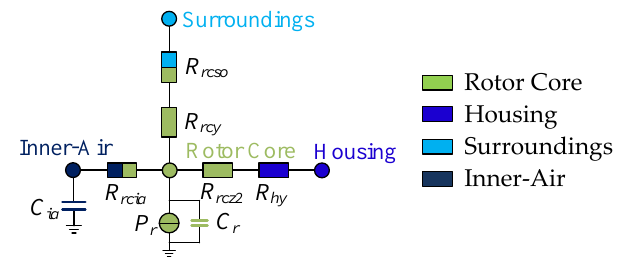
Figure 14. Thermal model of the rotor core.